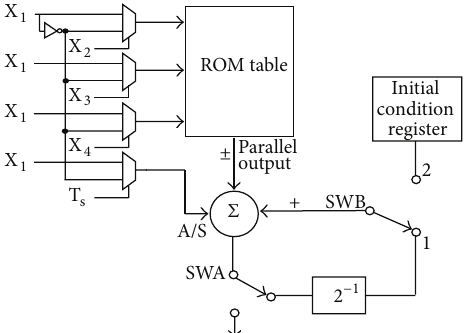
Figure 6: The proposed DA based filter architecture using MUX.